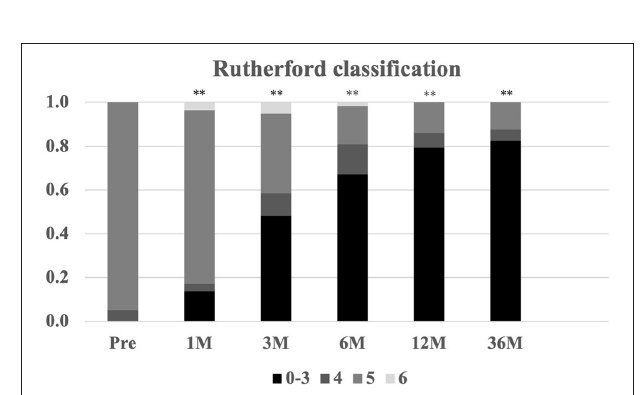
FIGURE 4 | The change in Rutherford classification during the 12-month follow-up. Serial changes in Rutherford classification (0–6) proportions ** P < 0.01 vs.